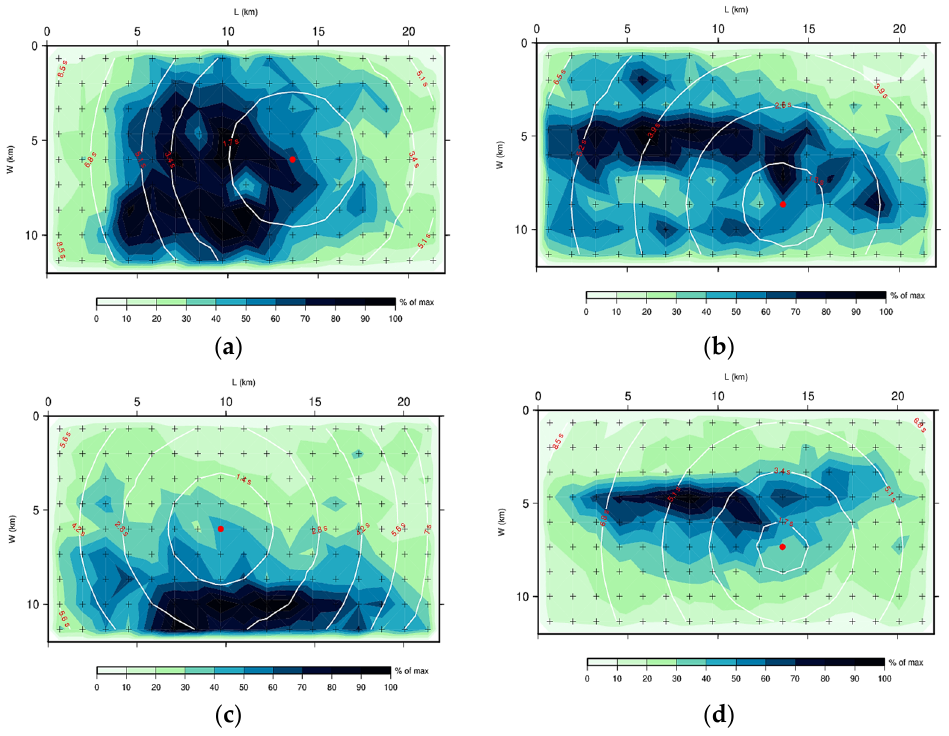
Figure 5. Four examples of fault-slip rupture processes were generated for the Mirandola source, varying the position of the nucleation point and the number of realization processes; ( a ) MIR: M w = 6.0, #1; ( b ) MIR: M w = 6.0, #50; ( c ) MIR: M w = 6.0, #90; ( d ) MIR: M w = 6.0, #100.